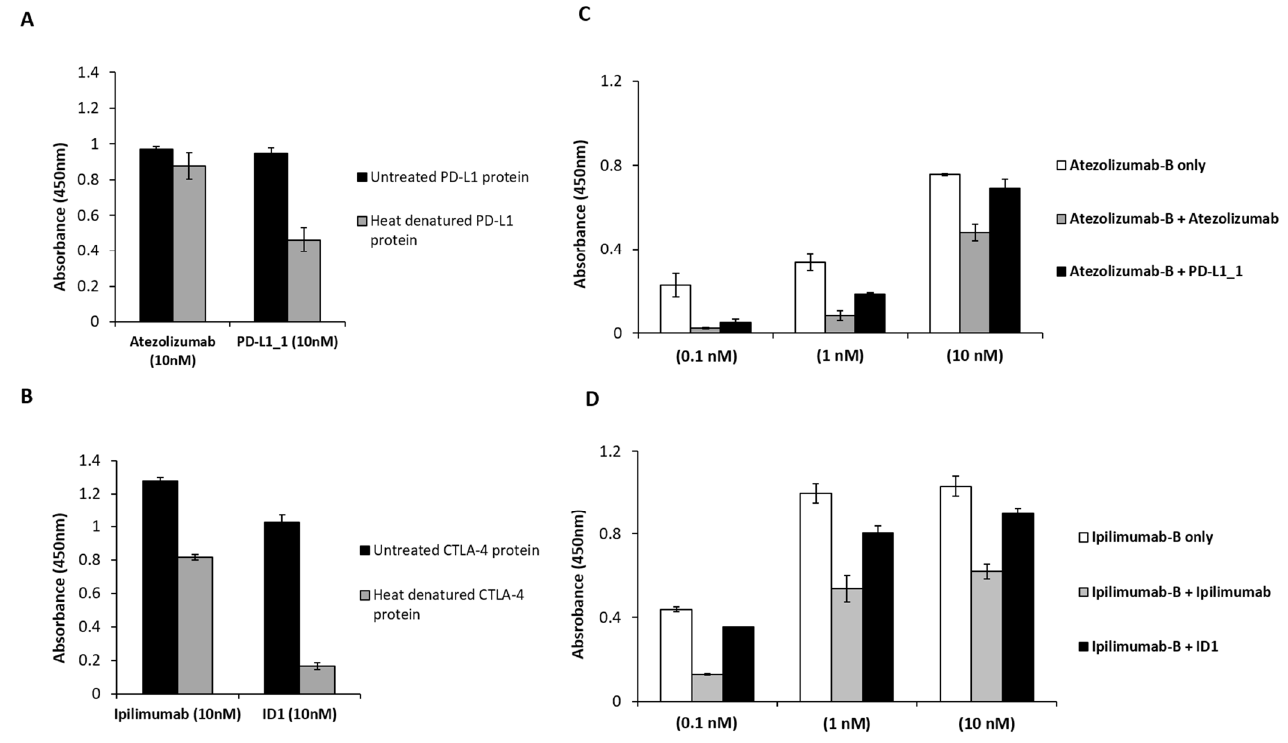
Figure 6. Binding assays to define the epitopes recognized by the novel mAbs. ELISA assays performed on PD-L1/Fc ( A ) or CTLA-4/Fc ( B ) before and after heat denaturation treatment of immobilized proteins. Competitive ELISA assays were performed by testing the binding of the biotinylated antibodies atezolizumab ( C ) or ipilimumab ( D ) to PD-L1 or CTLA-4 chimeric proteins in the absence (white bars) or presence of molar excess of unlabeled competitive PD-L1_1 or ID-1 antibodies (black bars). As positive controls biotinylated atezolizumab or ipilimumab (grey bars) were used in the presence of their unlabeled counterparts. Binding values were reported as the mean of at least three determinations obtained in three independent experiments. Error bars depicted means ±